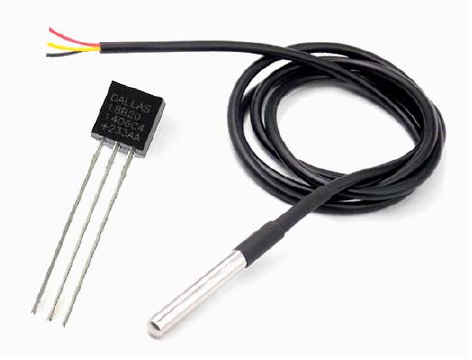
Figure 5. Sensor DS18B20 with TO ‐ 92 enclosure (left) or sealed stainless steel sheath (right).